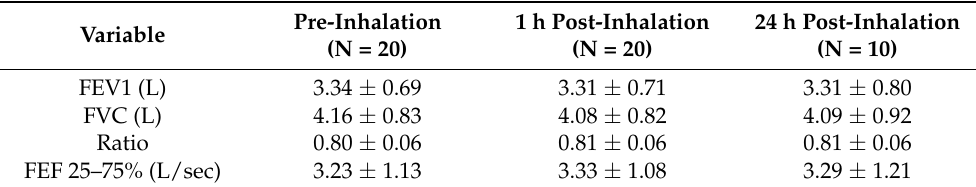
Table 2. Baseline, 1 h, and 24 h post-inhalation spirometry values with nebulized TAC-LAC colloidal dispersion (3 mg TAC/dose).